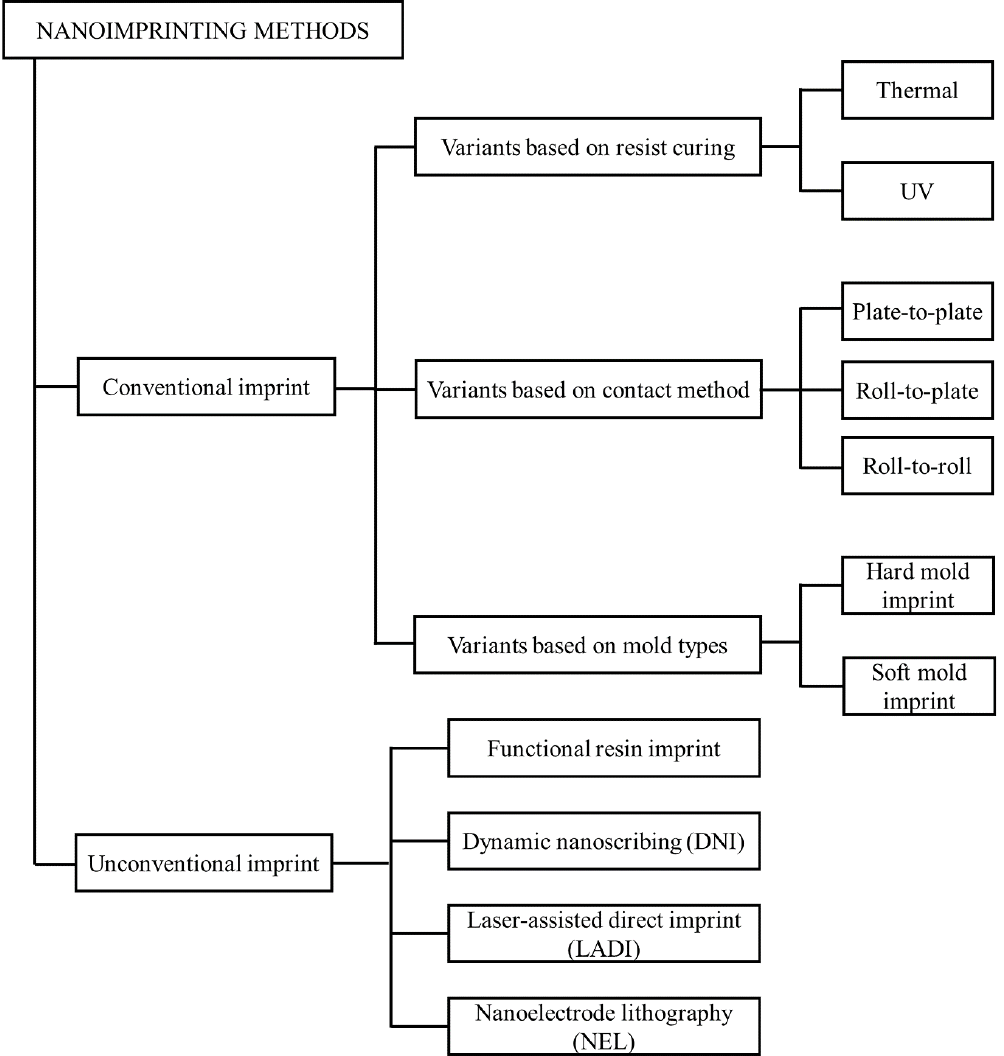
Figure 5. Classification of nanoimprinting methods. Conventional imprint methods indicate the general classification criteria of nanoimprint lithography (NIL) methods including curing methods, contact methods, and mold types. Unconventional imprinting contains the emerging methods which are hard to classify using the conventional